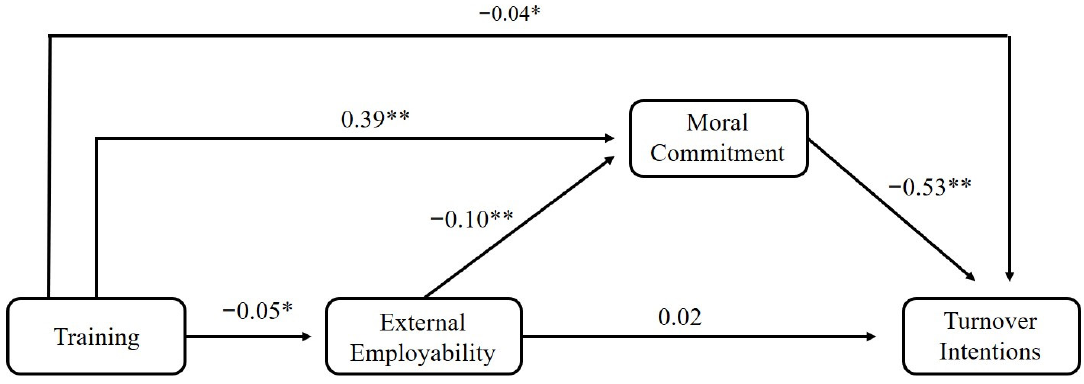
Figure 3. Model 2. Note. * p < 0.05; ** p < 0.01. Table 6. Indirect effects of Model